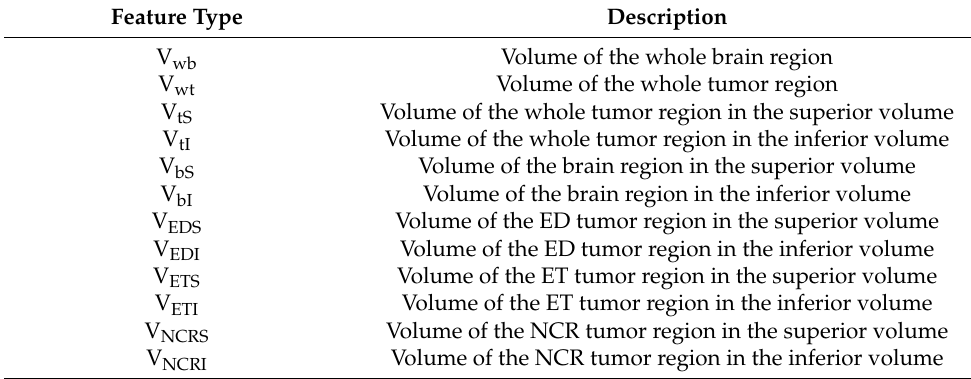
Table A3. Volumetric features extracted from mid-horizontal plane